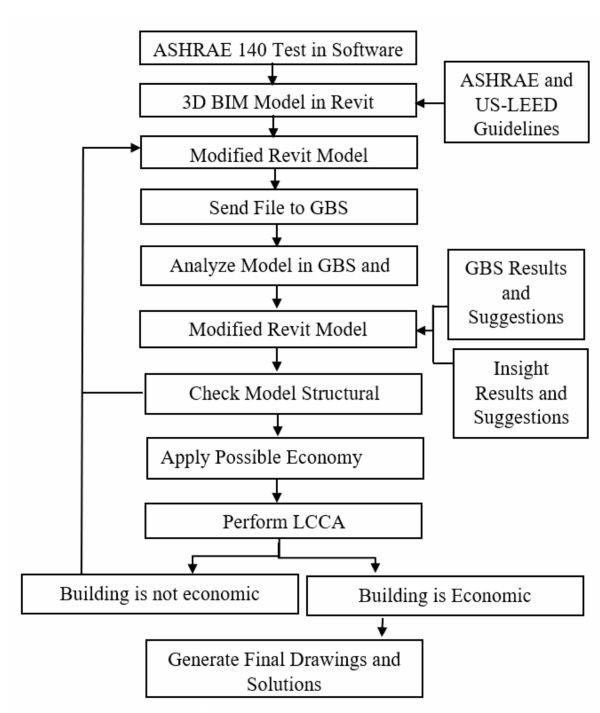
Figure 4. Flowchart of adopted methodology.